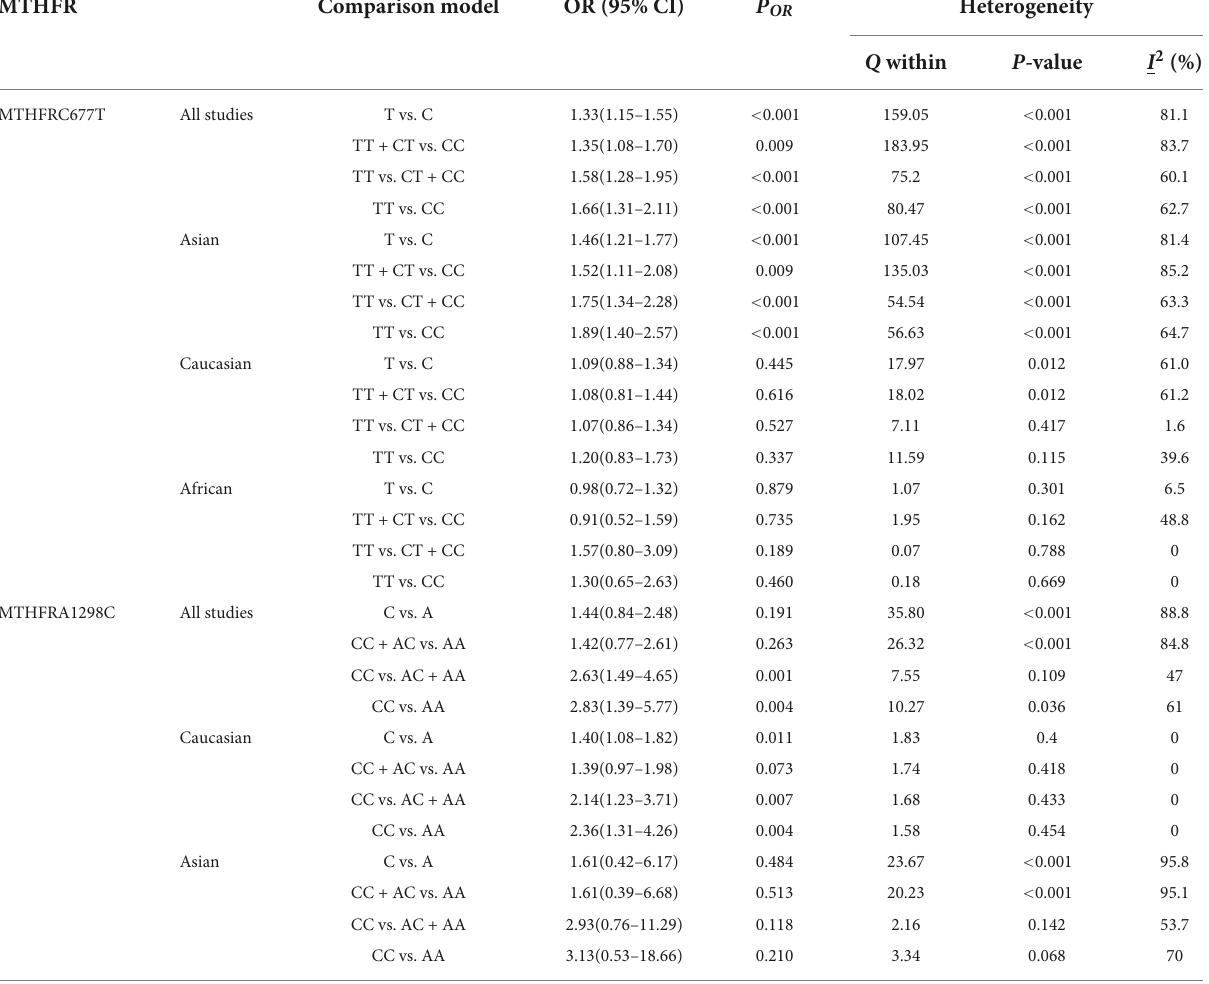
TABLE 4 Odds ratios and heterogeneity results for the 4 genetic models of the MTHFR C677T and A1298C for MD.